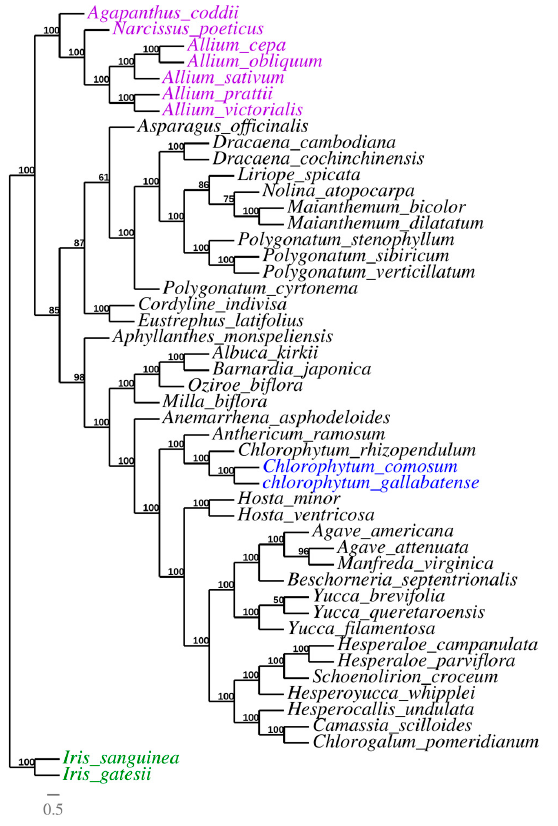
Figure 9. Phylogenetic trees of Asparagales species based on whole chloroplast genome sequences, with two species from family Iridaceae used as